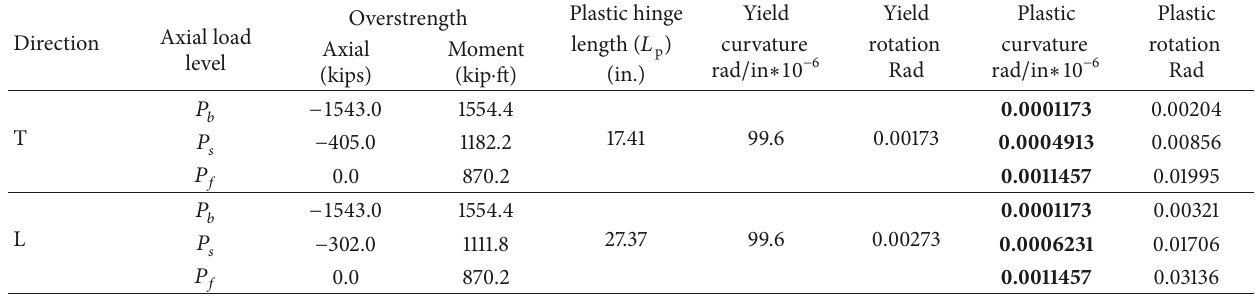
Table 11: User-defined plastic hinge properties of Pier #2 columns, Bridge #2-E.